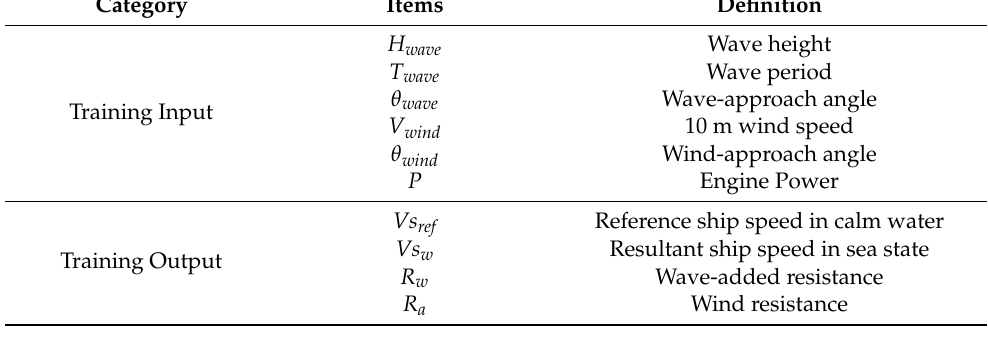
Table 2. Required training data for ANN modeling.